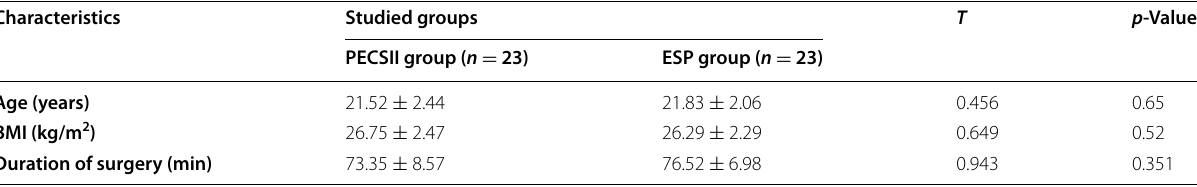
Data were expressed as mean SD. SD , standard deviation. t , t -test. P < 0.05 statistically is significant. BMI body mass index. PECSII modified pectoral plane block. ESP ± erector spinae plane block